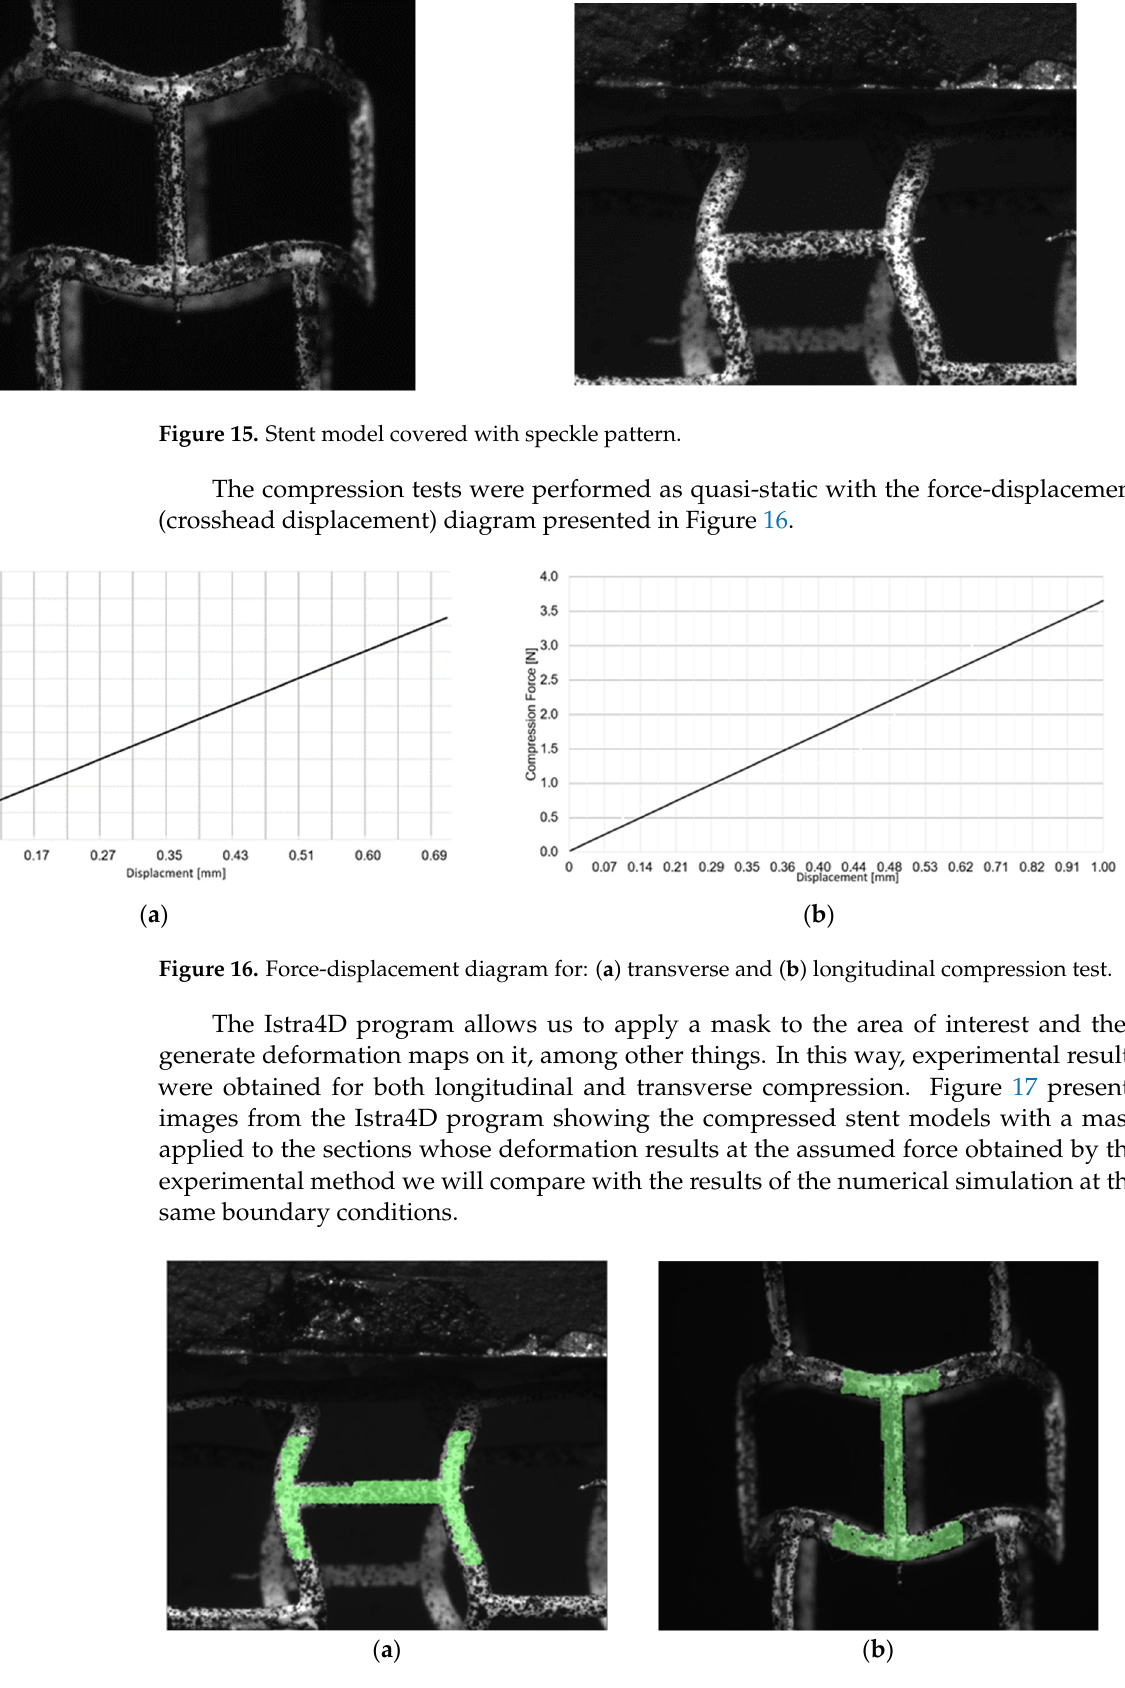
Figure 17. Istra4D DIC masked stents: ( a ) transversely compressed (pinch), ( b ) longitudinally com- pressed .